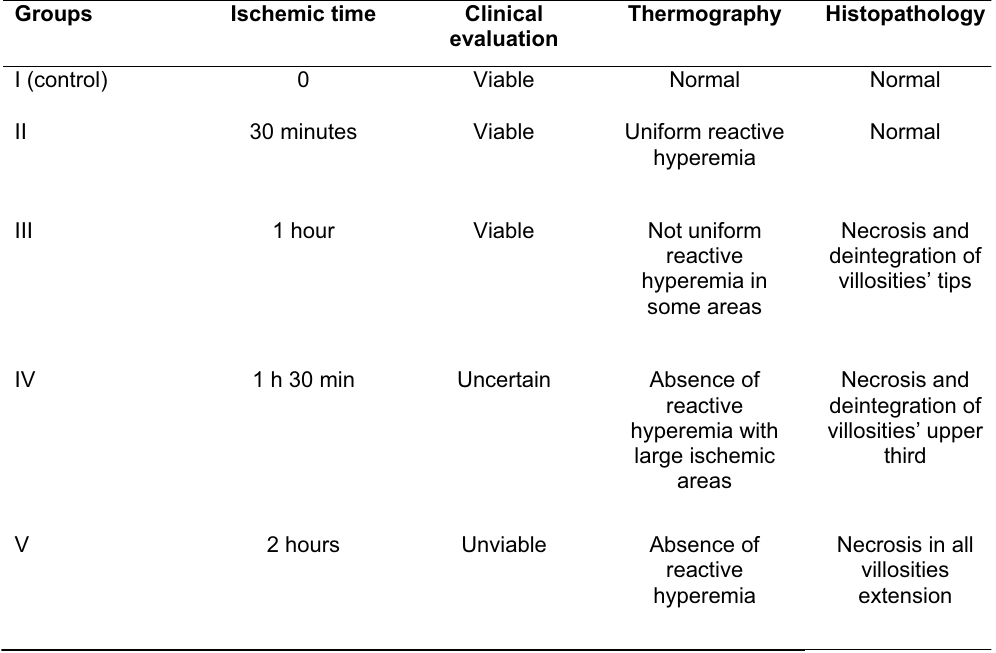
TABLE 2 - Revascularizated small intestine evaluation when subjected to time varied ischemia